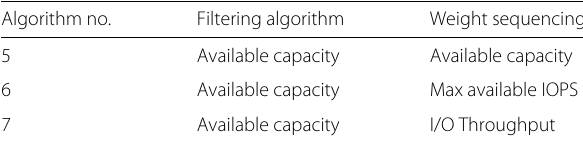
Table 2 Combination of filtering algorithm and